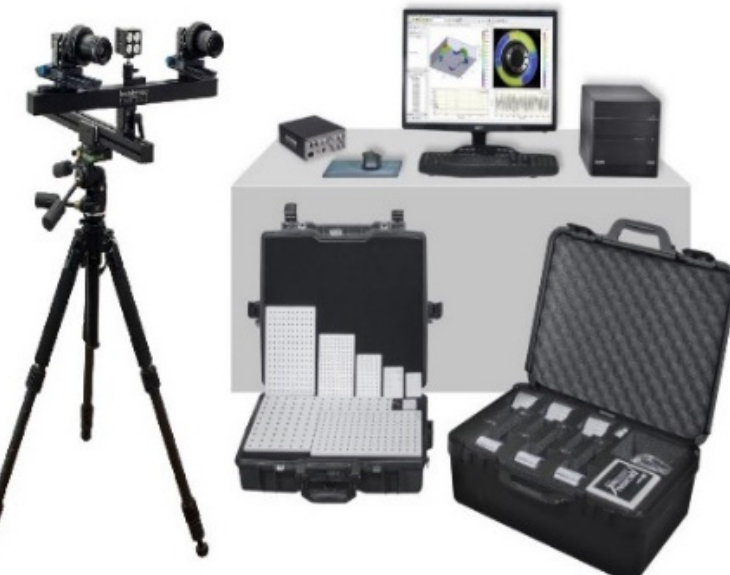
Figure 3. Strain collection system (this picture was provided by the USA CSI company (Jacksonville, FL, USA)).